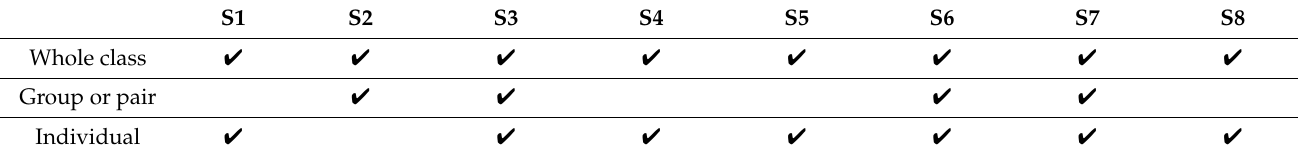
Table A2. Overview of how vocabulary instruction was structured in the observed